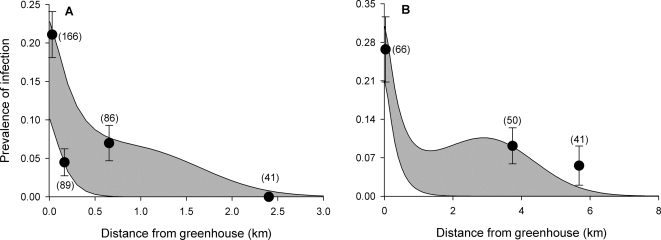
Spillover of pathogenic Crithidia bombi into wild bumble bee populations near greenhouses in southern Ontario.Filled circles indicate the observed mean±SE prevalences of C. bombi among bumble bee workers (across species and sampling dates) collected at varying distances to industrial greenhouses at (A) Exeter and (B) Leamington during summer 2005. Sample sizes are shown in parentheses. Shaded areas indicate the predicted C. bombi prevalences during our study period, based on the diffusion model [equations (1)–(3)] and the parameter values shown in Table 2. In panel A, for example, the lower curve of the shaded area represents the predicted prevalence of infection during our first collecting effort at Exeter, as a function of distance from the greenhouse, whereas the upper curve represents the predicted prevalence during our last collecting effort, nine weeks later. We estimated that, in our numerical simulations, t = 4–13 wks (Exeter) and t = 5–14 wks (Leamington) most closely matched with our nine week sampling period during June–August (see Materials and Methods).